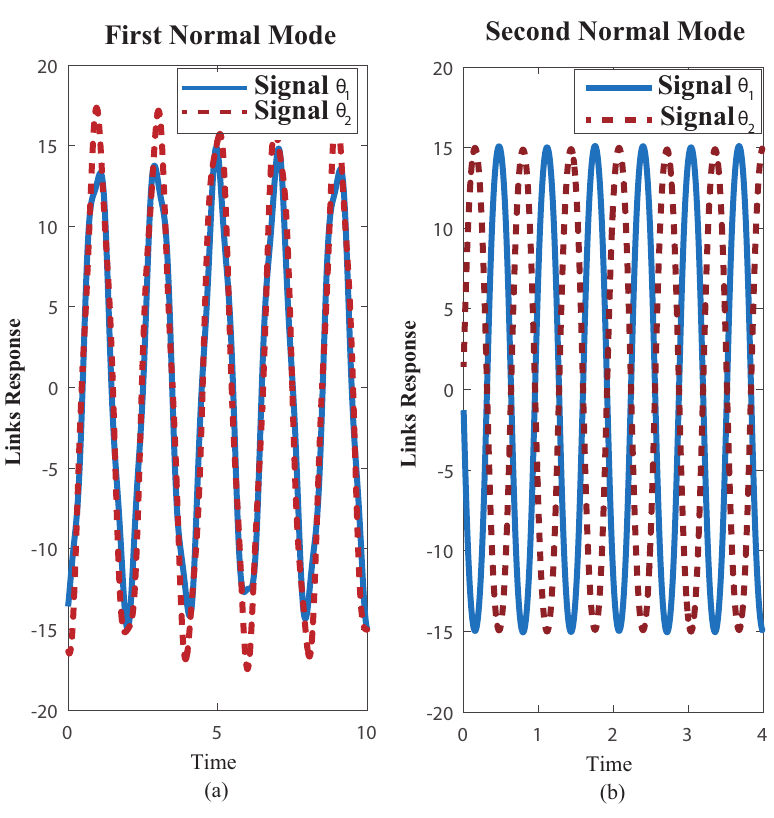
Figure 16. Normal Modes of Vibration. First mode both links swing closely in phase; second mode both links swing in opposite phases. Conditions: ω 1 = 0.5 Hz, ω 2 = 1.86 Hz, α = 0.5833, l = 0.8571